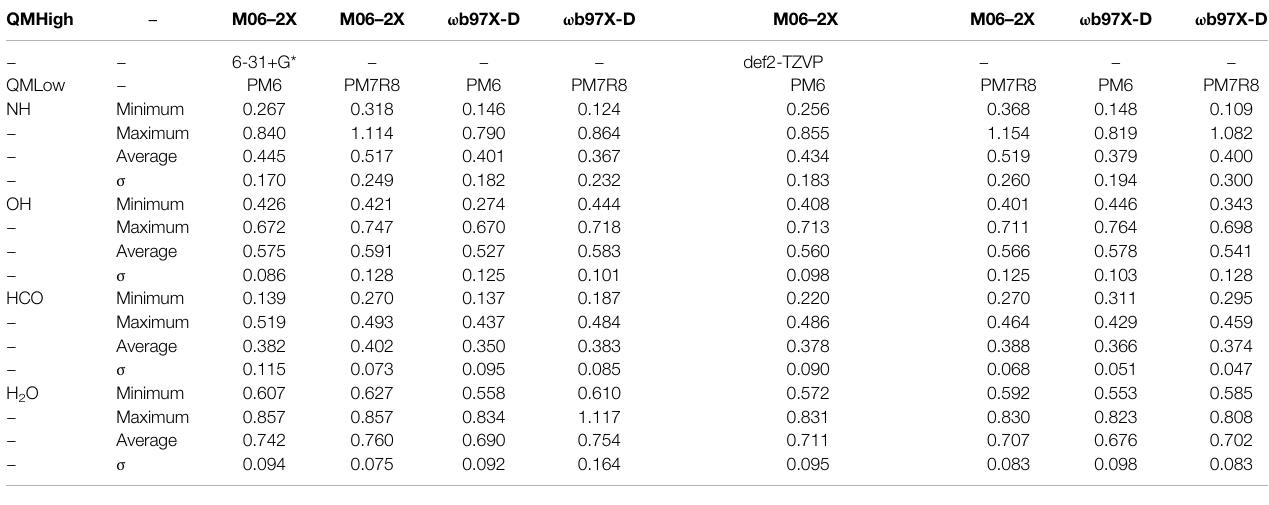
TABLE 2 | Calculated BE ’ s at ONIOM level for diatomic and triatomic systems. QMHigh